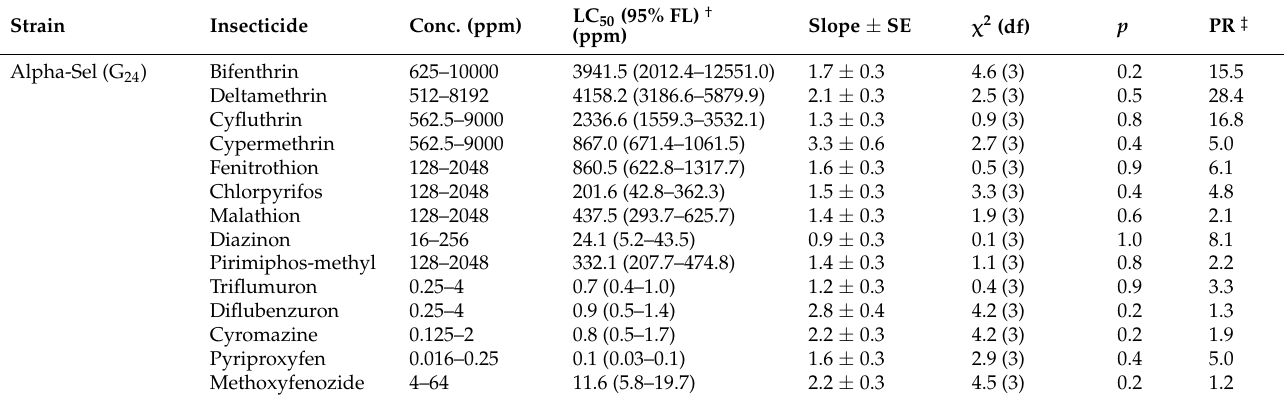
Compared with Alpha-Unsel, Alpha-Sel (G 24 ) exhibited (1) moderate CR between al- pha-cypermethrin and bifenthrin (PR = 15.5-fold), deltamethrin (PR = 28.4-fold), or cyfluthrin (16.8-fold); (2) low CR between alpha-cypermethrin and cypermethrin (PR = 5.0-fold), fenitrothion (PR = 6.1-fold), chlorpyrifos (PR = 4.8-fold), malathion (PR = 2.1- fold), diazinon (PR = 8.1-fold), pirimiphos-methyl (PR = 2.2-fold), triflumuron (PR = 3.3- fold), or pyriproxyfen (PR = 5.0-fold); and (3) no CR between alpha-cypermethrin and diflubenzuron (PR = 1.3-fold), cyromazine (PR = 1.9-fold), or methoxyfenozide (PR = 1.2- fold) (Table 6).